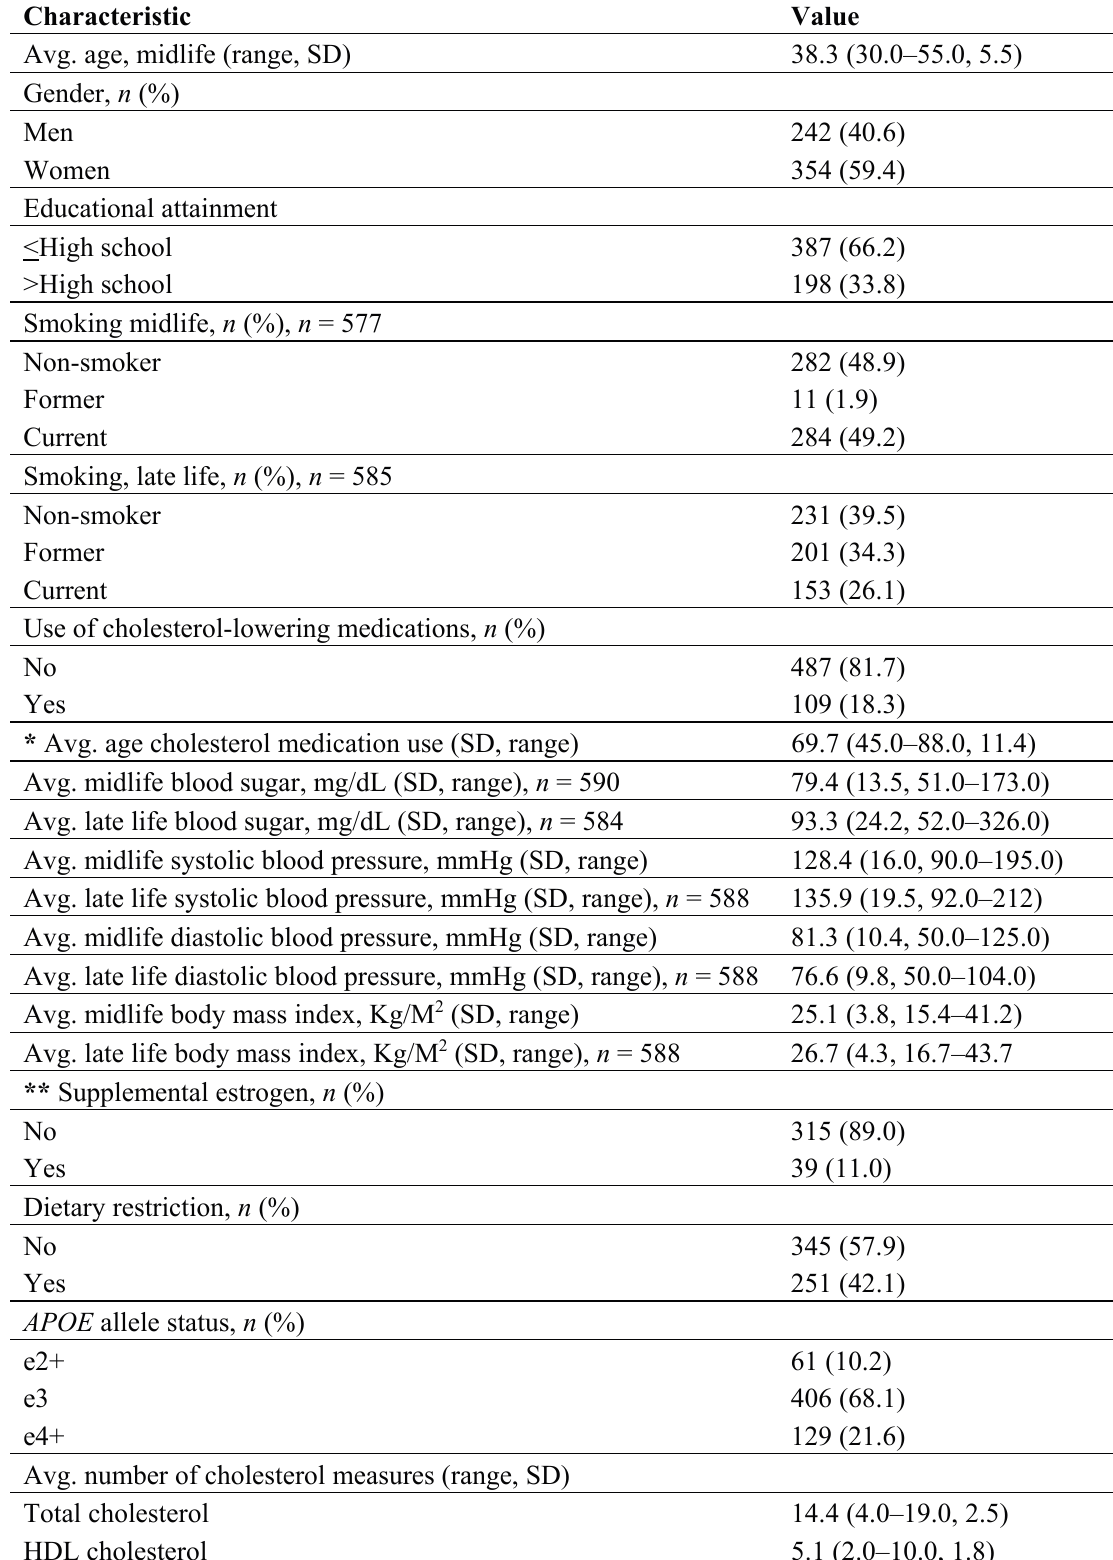
Table 2. Demographic characteristics of final sample ( n =